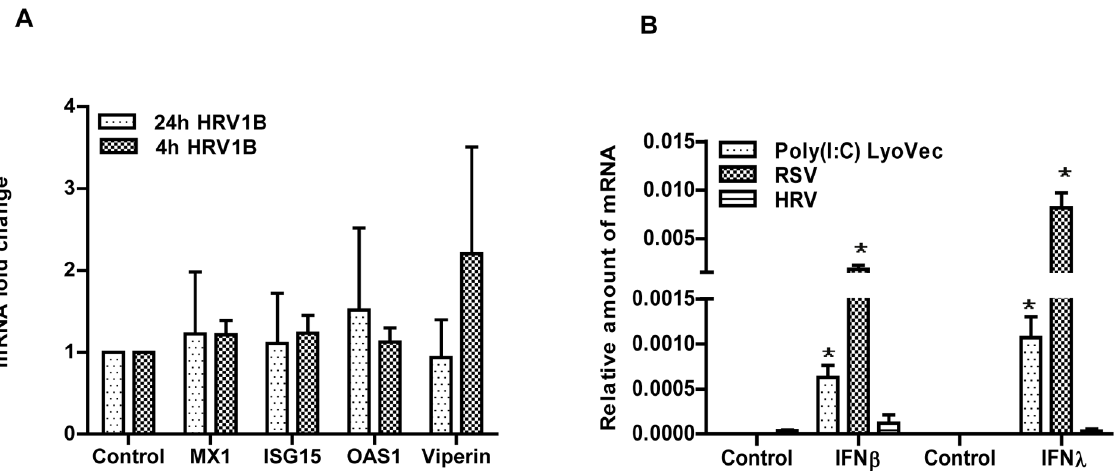
Figure 5. HRV1B induced interferon response in PBECs and its comparison with other stimuli. PBECs were infected with HRV1B for 4 h and collected after 24 h, or for the whole experimental procedure (n=4). The mRNA expression of ISGs was determined with qPCR and fold changes were calculated with the 2 2 DD Ct method (A). Cells were infected with RSV (MOI-1, 1 h) or HRV1B (4 h). After infection, virus-containing medium was removed and replaced with fresh medium. Additionally, cells were stimulated with poly(I:C)/LyoVec (500 ng/ml) for 24 h (n=3). Then cells were collected and IFN b / l 1 mRNA expression was determined by qPCR and relative amount of mRNA was calculated with the 2 2 D Ct method (B). *, p , 0.05 control vs rest of the conditions.